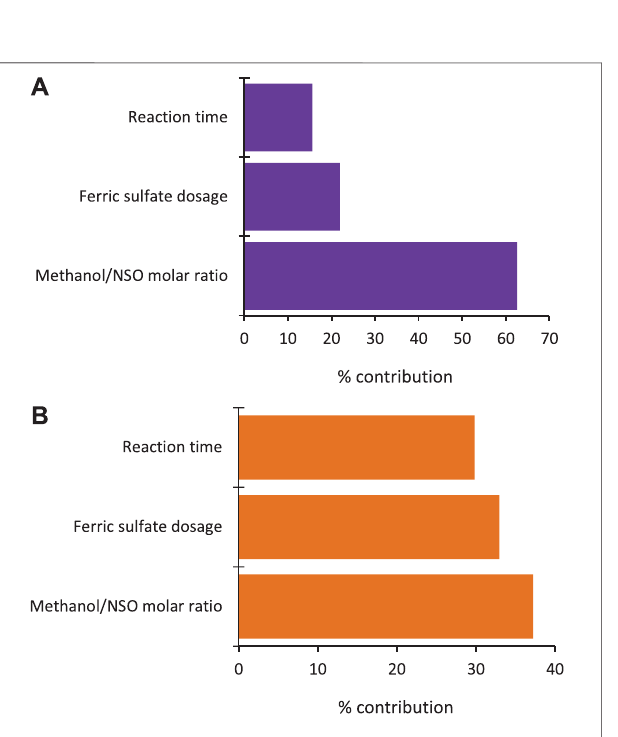
FIGURE 9 | Plots of observed and model predicted %FFA versus experimental run number.